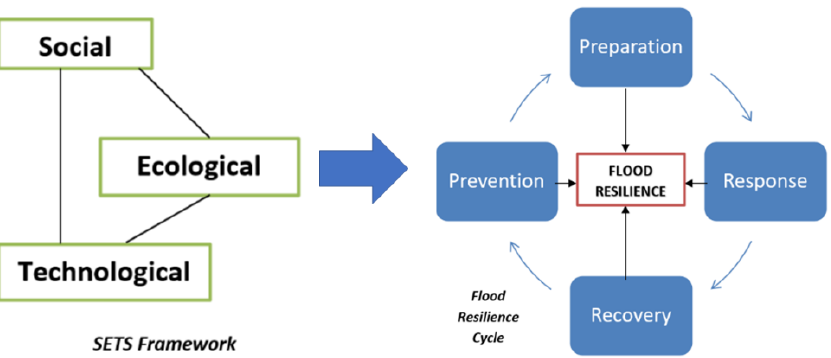
Figure 1. Research framework (Source: authors)